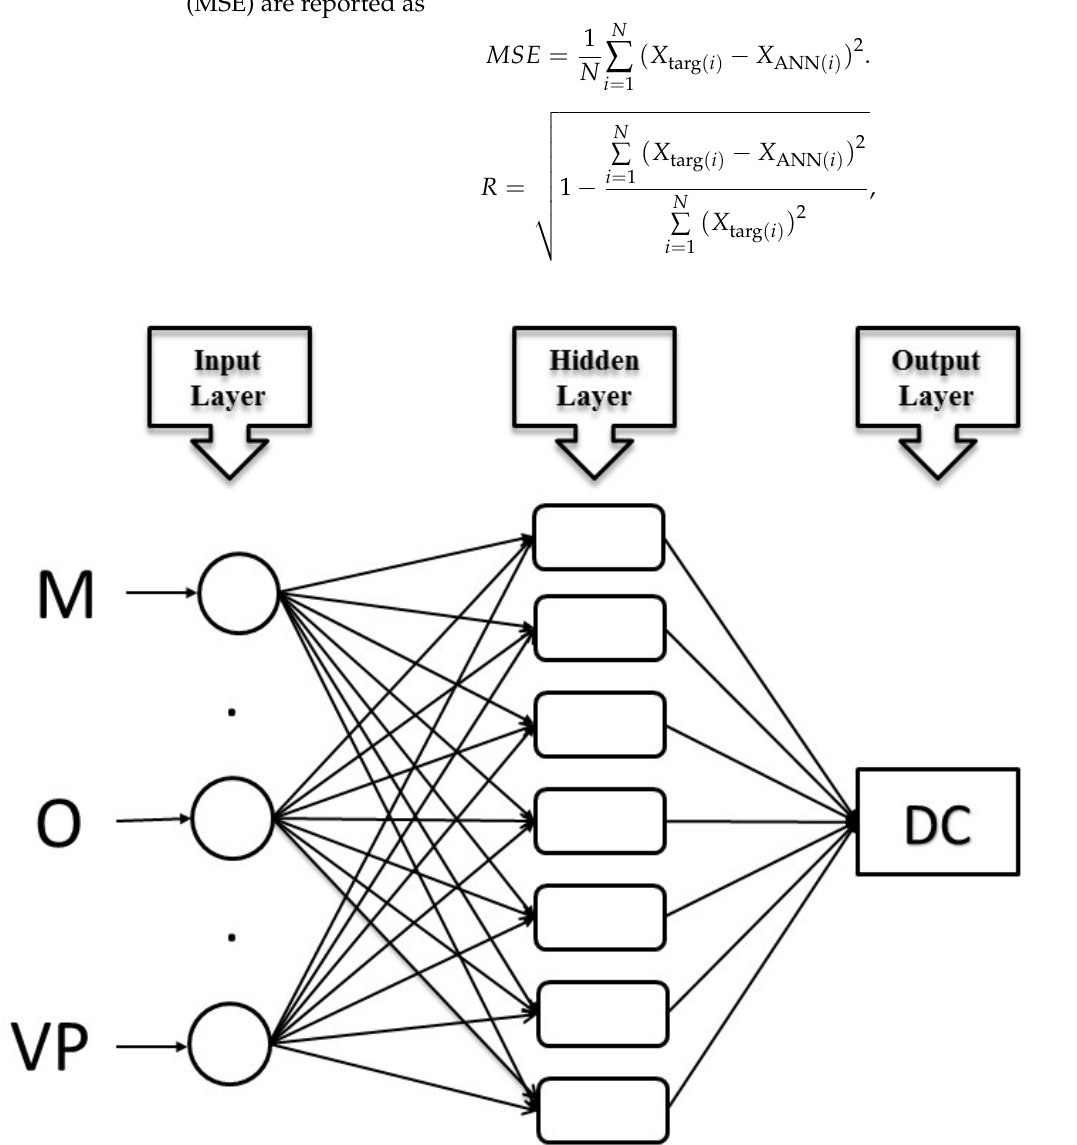
Figure 2. The configuration structure of the MLP neural network designed for estimating the DC value.